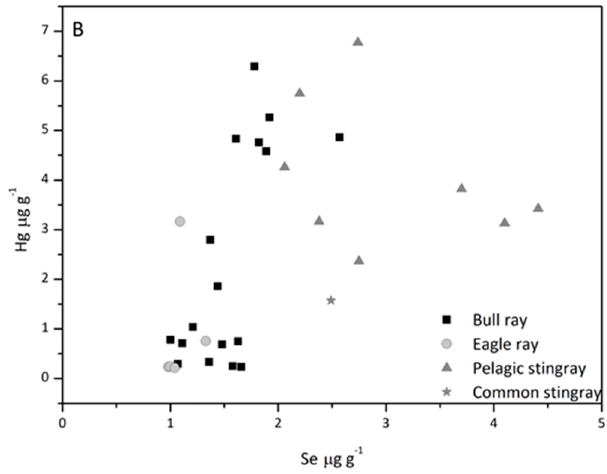
Figure 3. Se and Hg contents in liver ( A ) and muscle ( B ) of rays.